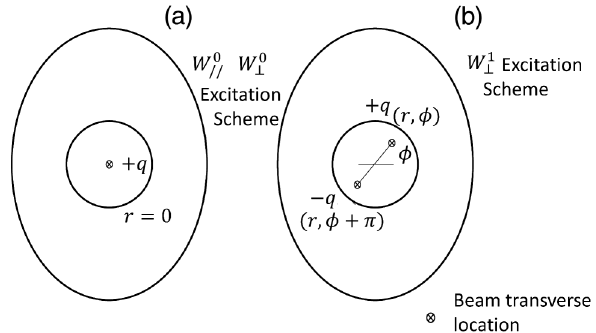
FIG. 3. Different beam excitation schemes for wakefield calculation: (a) single-beam scheme for ~W 1 scheme for ~W ⊥ . r is set in the range of R= the wake impedance dependence on the angle ϕ needs to be investigated in the asymmetric cavity.